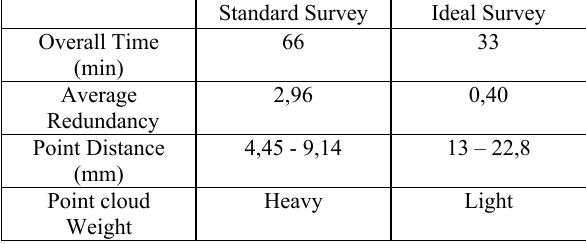
Table 3. Comparison between standard survey and the ideal